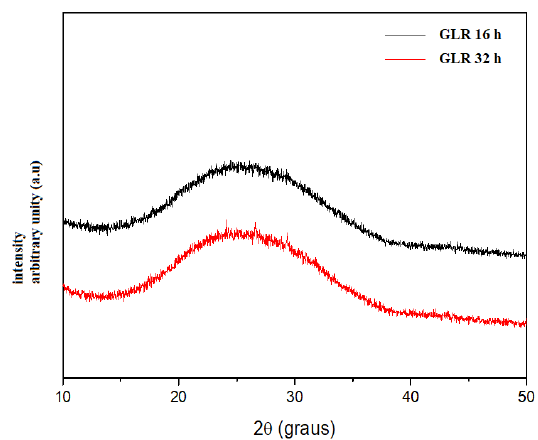
Figure 3. Comparison of XRD of GLR for 16 h and 32 h milling time